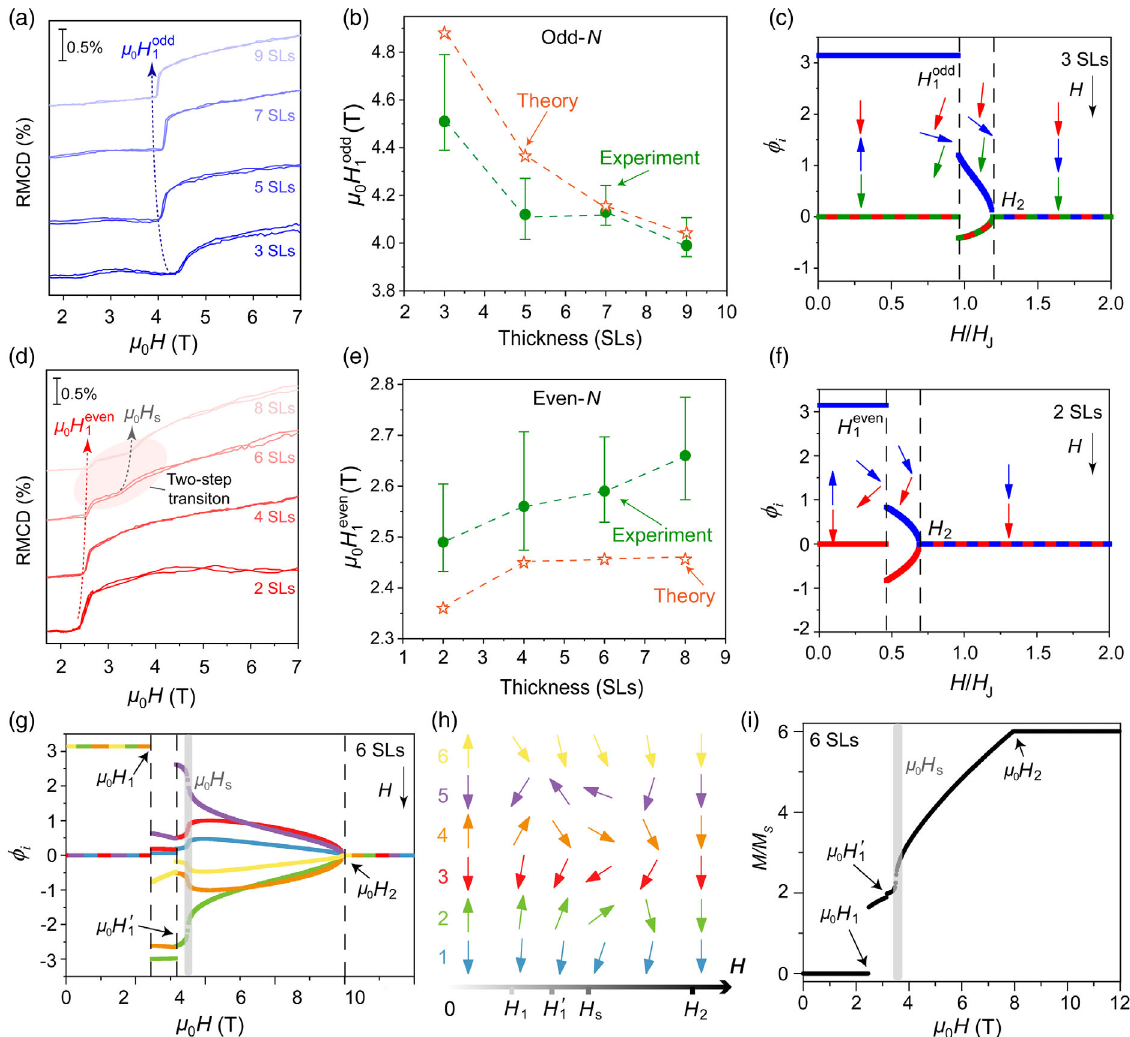
FIG. 2. Odd-even layer-number effect and magnetic-state evolution of thin MnBi 2 Te 4 flakes. (a,d) Zoomed-in RMCD measurements of all investigated odd- N samples (a) and even- N samples (d), showing a prominent odd-even layer-number effect in MnBi 2 Te 4 . In odd- N SLs, the spin-flop transition occurs at about 4.5 T. The blue dashed arrow represents the spin-flop field in each thickness. In even- N SLs, the spin-flop transition occurs at about 2.5 T, which is marked by the red dashed arrow. For 6 SLs and 8 SLs, the RMCD signals exhibit a second transition marked by the grey dashed arrow. (b,e) Spin-flop field versus N for odd- N SL (b) and even- N SL (e) samples. The green circles with error bars denote the experimental results extracted from the RMCD measurements, while orange pentagons denote the calculated theoretical values of spin-flop fields using the parameters of μ 0 H dashed lines indicate the evolution of the spin-flop field (green for experiment and orange for theory). For the even- N samples, there is a small deviation of μ 0 H even 1 between the theory and experiment, which may result from the nonzero magnetization in their ground AFM states at zero field. (c,f) Magnetic-state evolution under the applied magnetic field in 3-SL (c) and 2-SL (f) MnBi 2 Te 4 obtained from the antiferromagnetic linear-chain model. Different colors denote the evolution of each layer in the 3-SL (c) and 2-SL (f) samples, and the arrow orientations indicate the detailed spin alignments. Dashed lines reveal the coincident evolution of different layers. (g) Magnetic- state evolution of the 6-SL sample under external magnetic field. Different colors represent the spin arrangement of different layers. (h) Detailed spin alignments of layers 1 to 6, with the corresponding colors of (g) at several representative external magnetic fields. (i) Calculated total magnetization along the z axis (defined as M ¼ M MnBi 2 Te 4 . The magnetization change at μ 0 H 0 1 is almost invisible compared to that at μ 0 H 1 and the coherent increase at μ 0 H